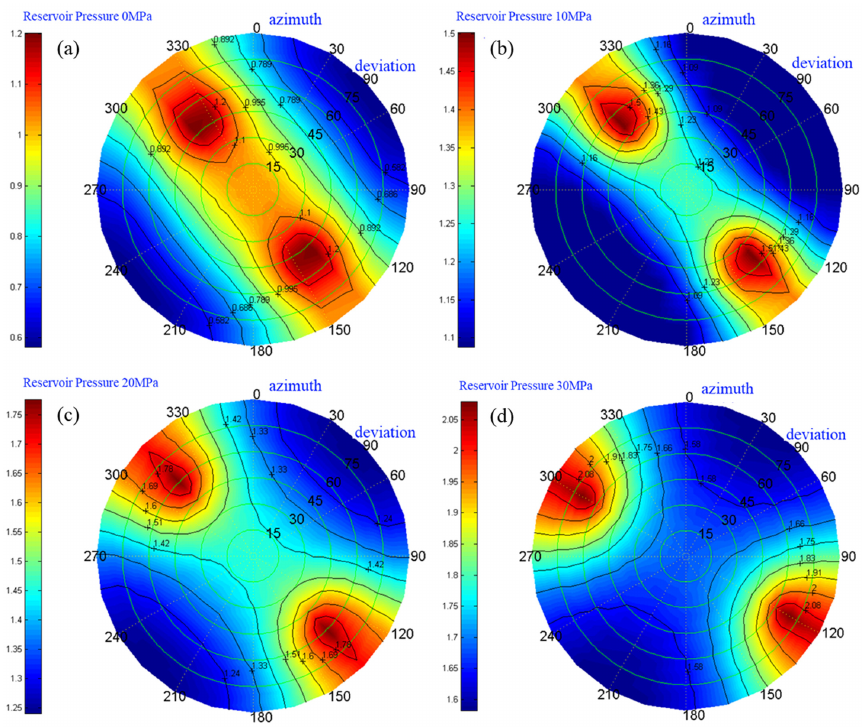
Figure 10. Reservoir fracture pressure change law of any well with pressure decline. ( a – d ) are represent reservoir pressure from 0 MPa to 30 MPa, respectively.